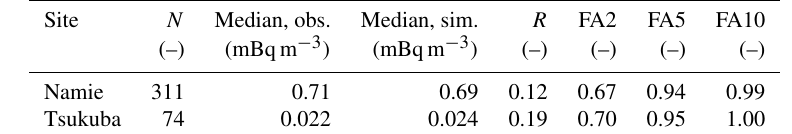
Table 3. Statistical analysis for the comparison of observed and simulated 137 Cs air concentration at Namie and Tsukuba for 2013.